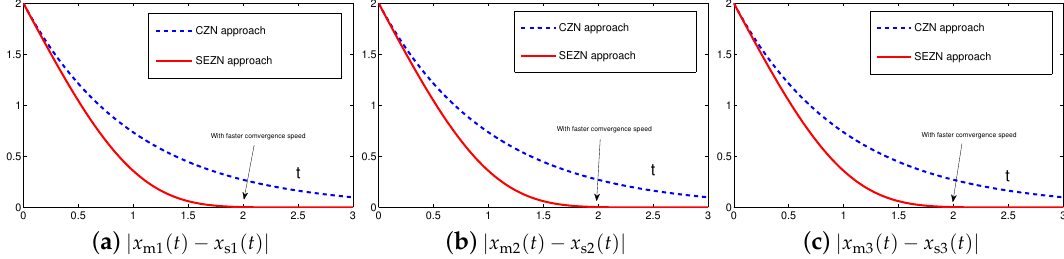
Figure 12. Absolute errors between two nonidentical chaotic systems (24) and (28) equipped with controller (7) via the CZN approach in comparison with controller (6) via the proposed SEZN